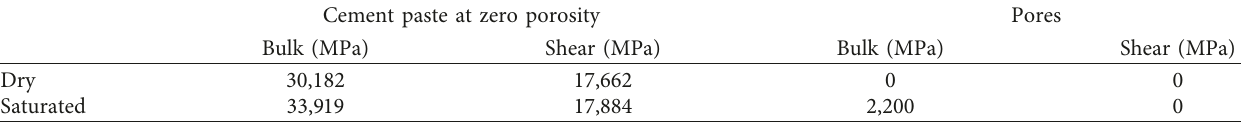
Table 1: Cement paste elastic moduli at zero porosity [19].